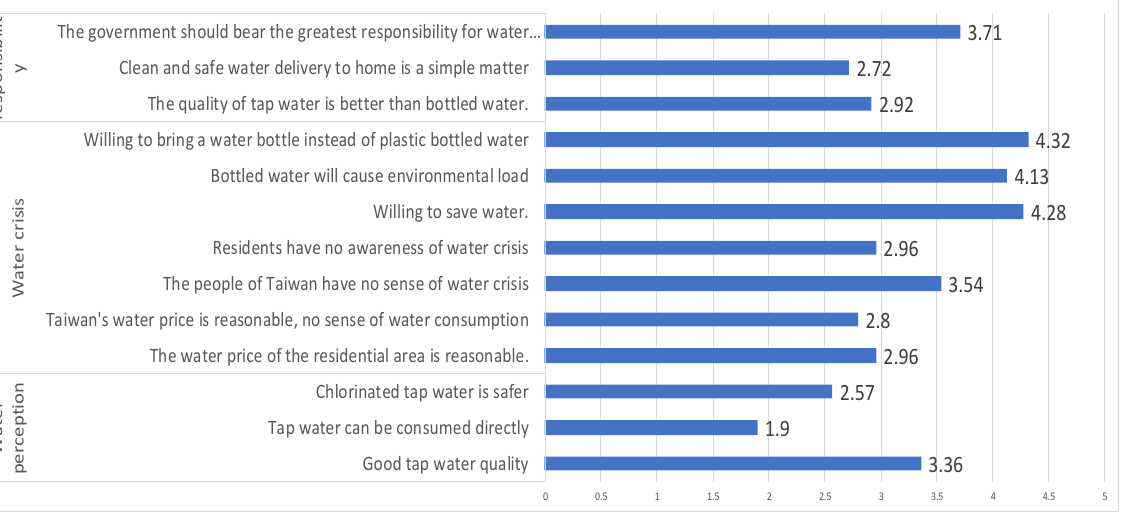
Figure 4. Analysis of water use attitude.